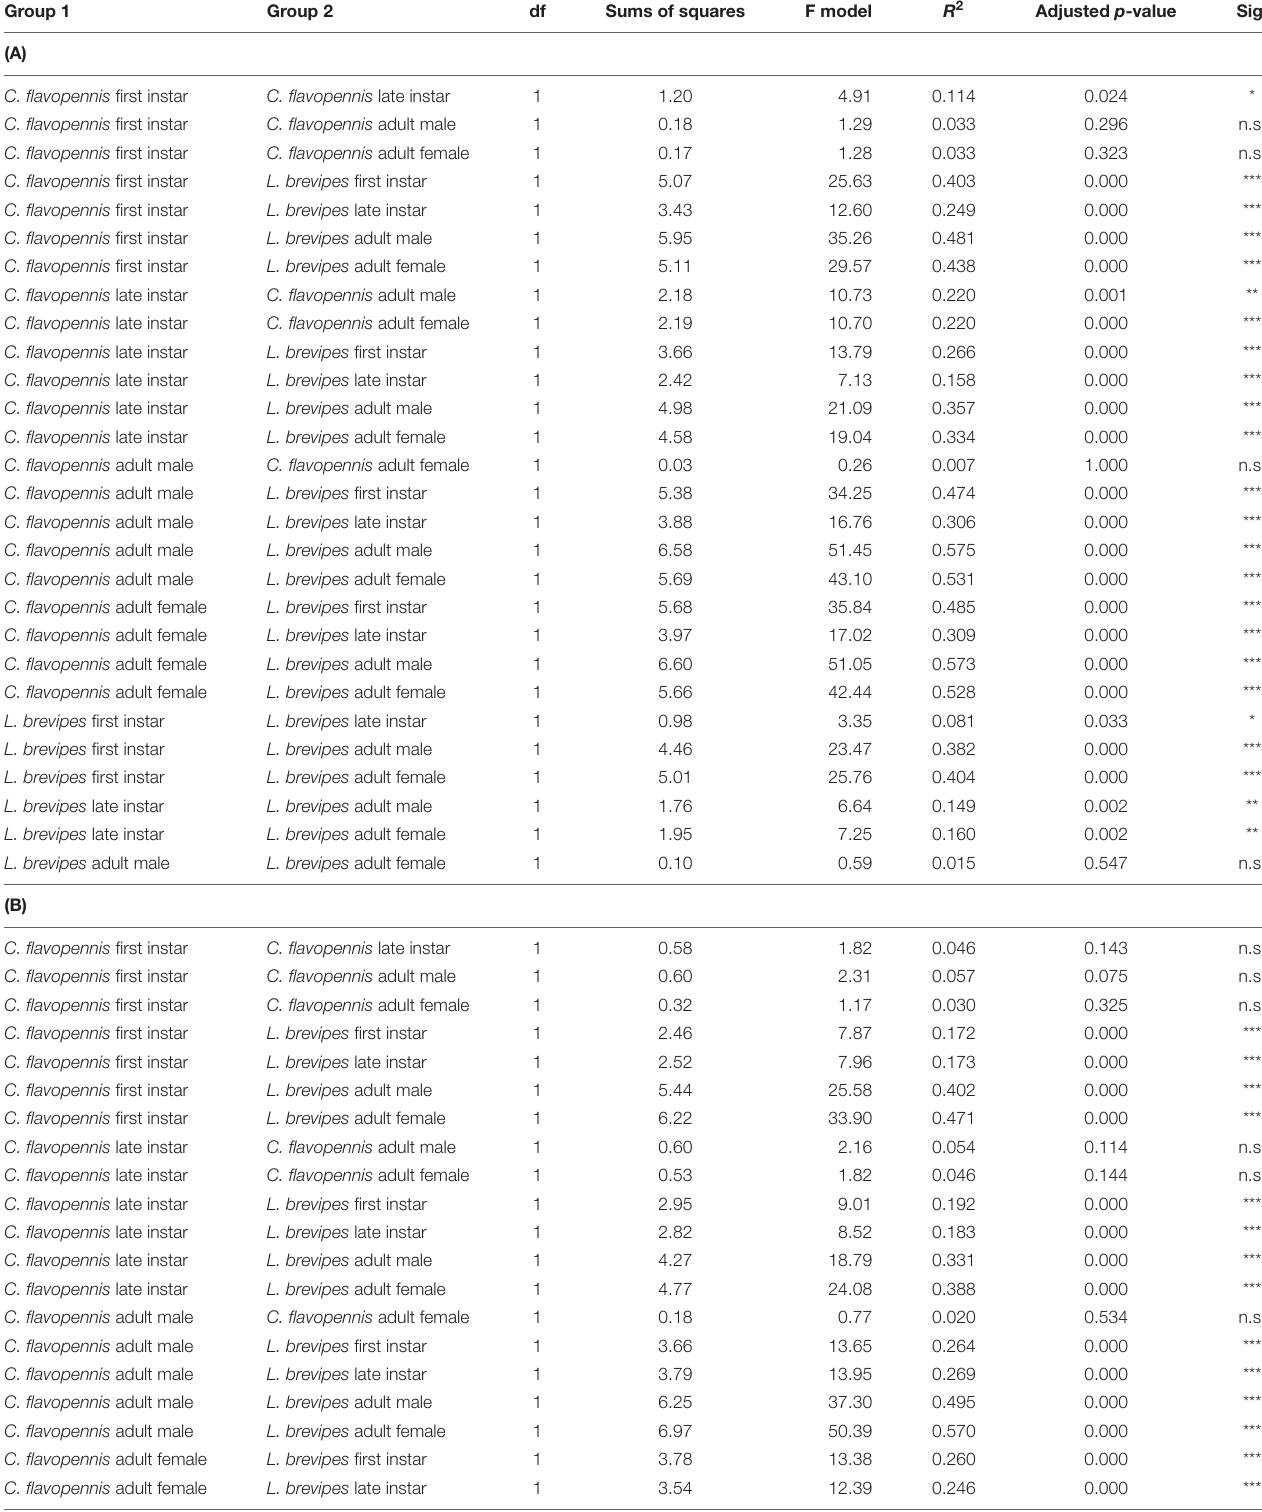
TABLE 3 | Pairwise comparisons of the overall behavioral responses between (A) all morphological types in the control treatment and (B) all morphological types in the wind treatment, and (C) comparisons of the overall behavioral responses between the wind and control treatments for individuals of the same morphological type. Group 1 Group 2 df Sums of squares F model R 2 Adjusted p -value